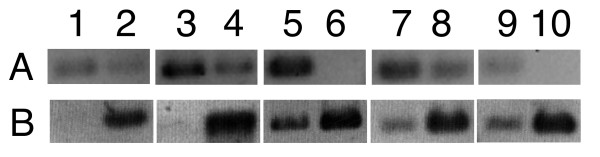
RT-PCR verification of unique gene expression. (A) C4-2 genes: Lane 1–2 ARHE, 3–4 PHF11, 5–6 PLD1, 7–8 PRG-3, and 9–10 ACAS2L. (B) LNCaP genes: Lane 1–2 ETV1, 3–4 EPHA7, 5–6 FLJ12895, 7–8 MBNL2, and 9–10 PCDH11X. Odd lanes are C4-2 and even lanes are LNCaP cDNA. Many genes determined to be unique to a cell line by Affymetrix and MPSS analysis were actually not when assayed by RT-PCR.